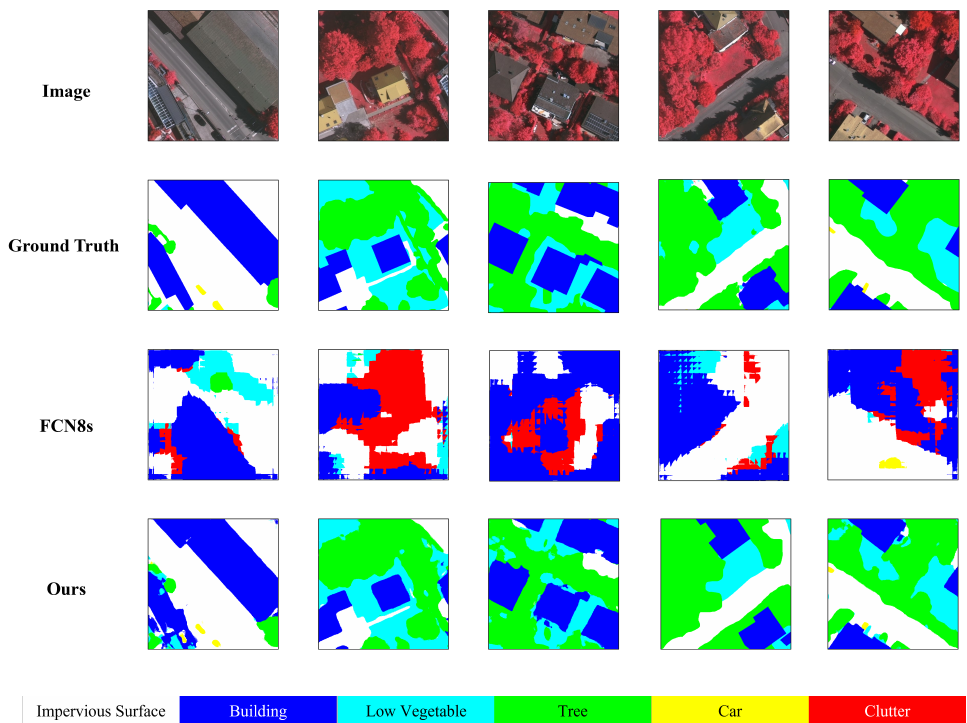
Figure 9. The 512 × 512 segmentation results on the Vaihingen dataset. The FCN results are predicted by our implementation in the same hyperparameter settings, and the annotation colors are consistent with the ground